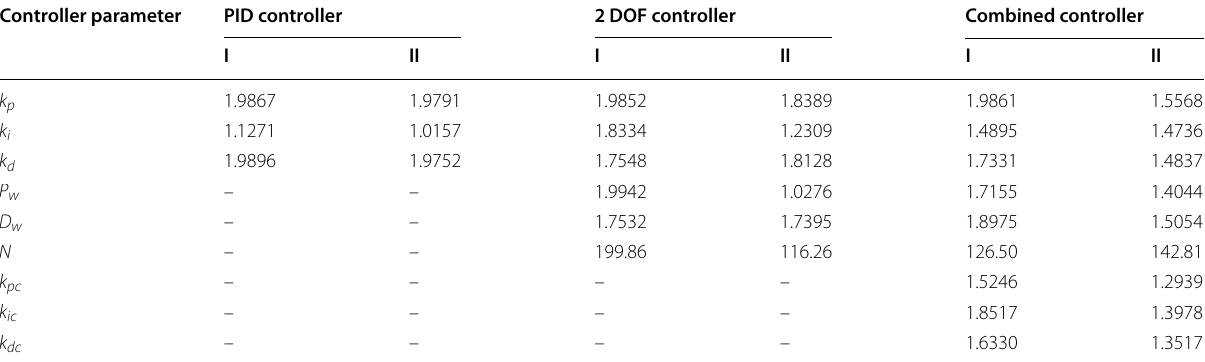
Table 2 CRSOA tuned controller parameters of the system with wind penetration Controller parameter